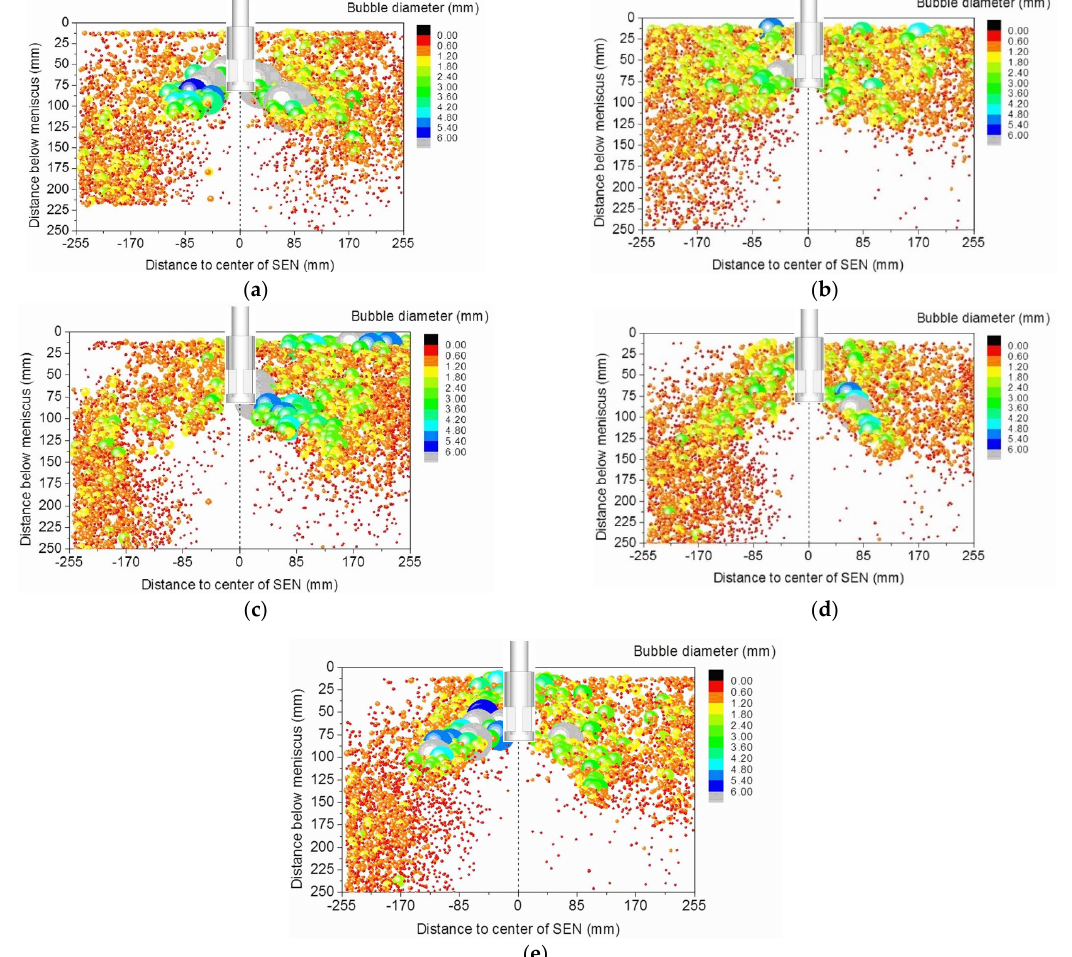
Figure 12. Distribution of bubbles in the mold: ( a ) 30 mL·min − 1 , ( b ) 60 mL·min − 1 , ( c ) 90 mL·min − 1 , ( d ) 160 mL·min − 1 , ( e ) 190 mL·min − 1 .